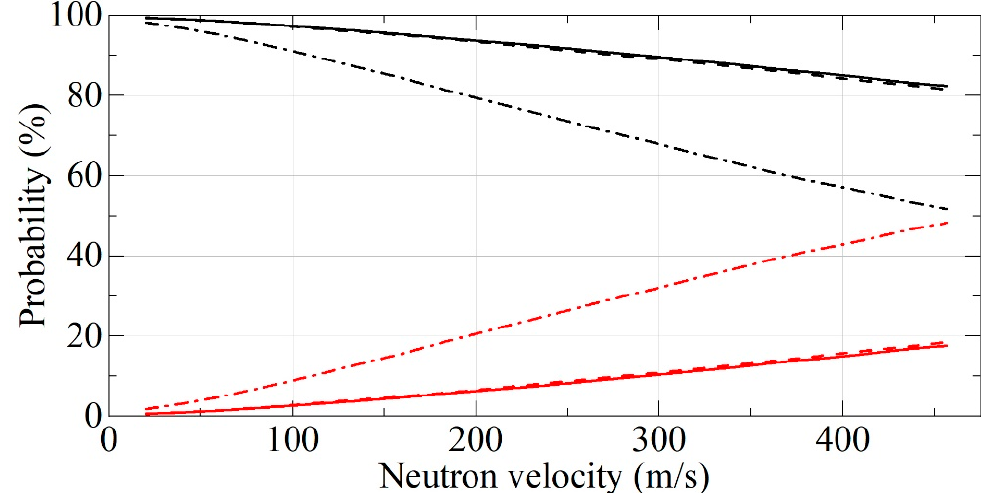
Figure 10. The probability of neutron reflection (black lines) and absorption (red lines) for F-DNDs (dashed lines) and DF-DNDs (solid lines) and DNDs (dash-dotted lines) versus neutron velocity. The incident neutrons are isotropic, the powder density is 0.19 g/cm 3 , and the powder thickness is infinite.